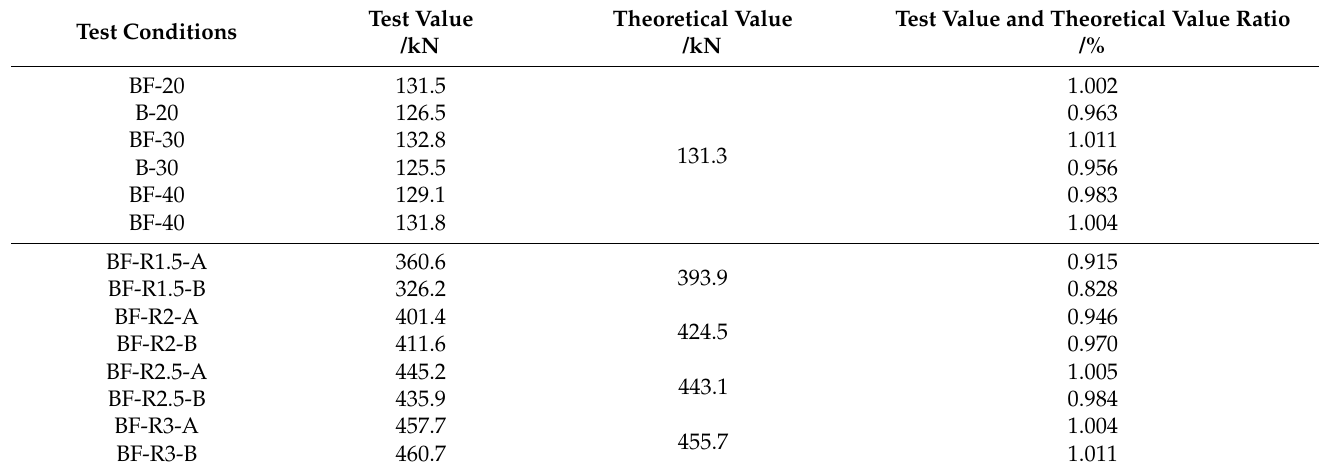
Table 5. Test and theoretical values of bending bearing capacity.